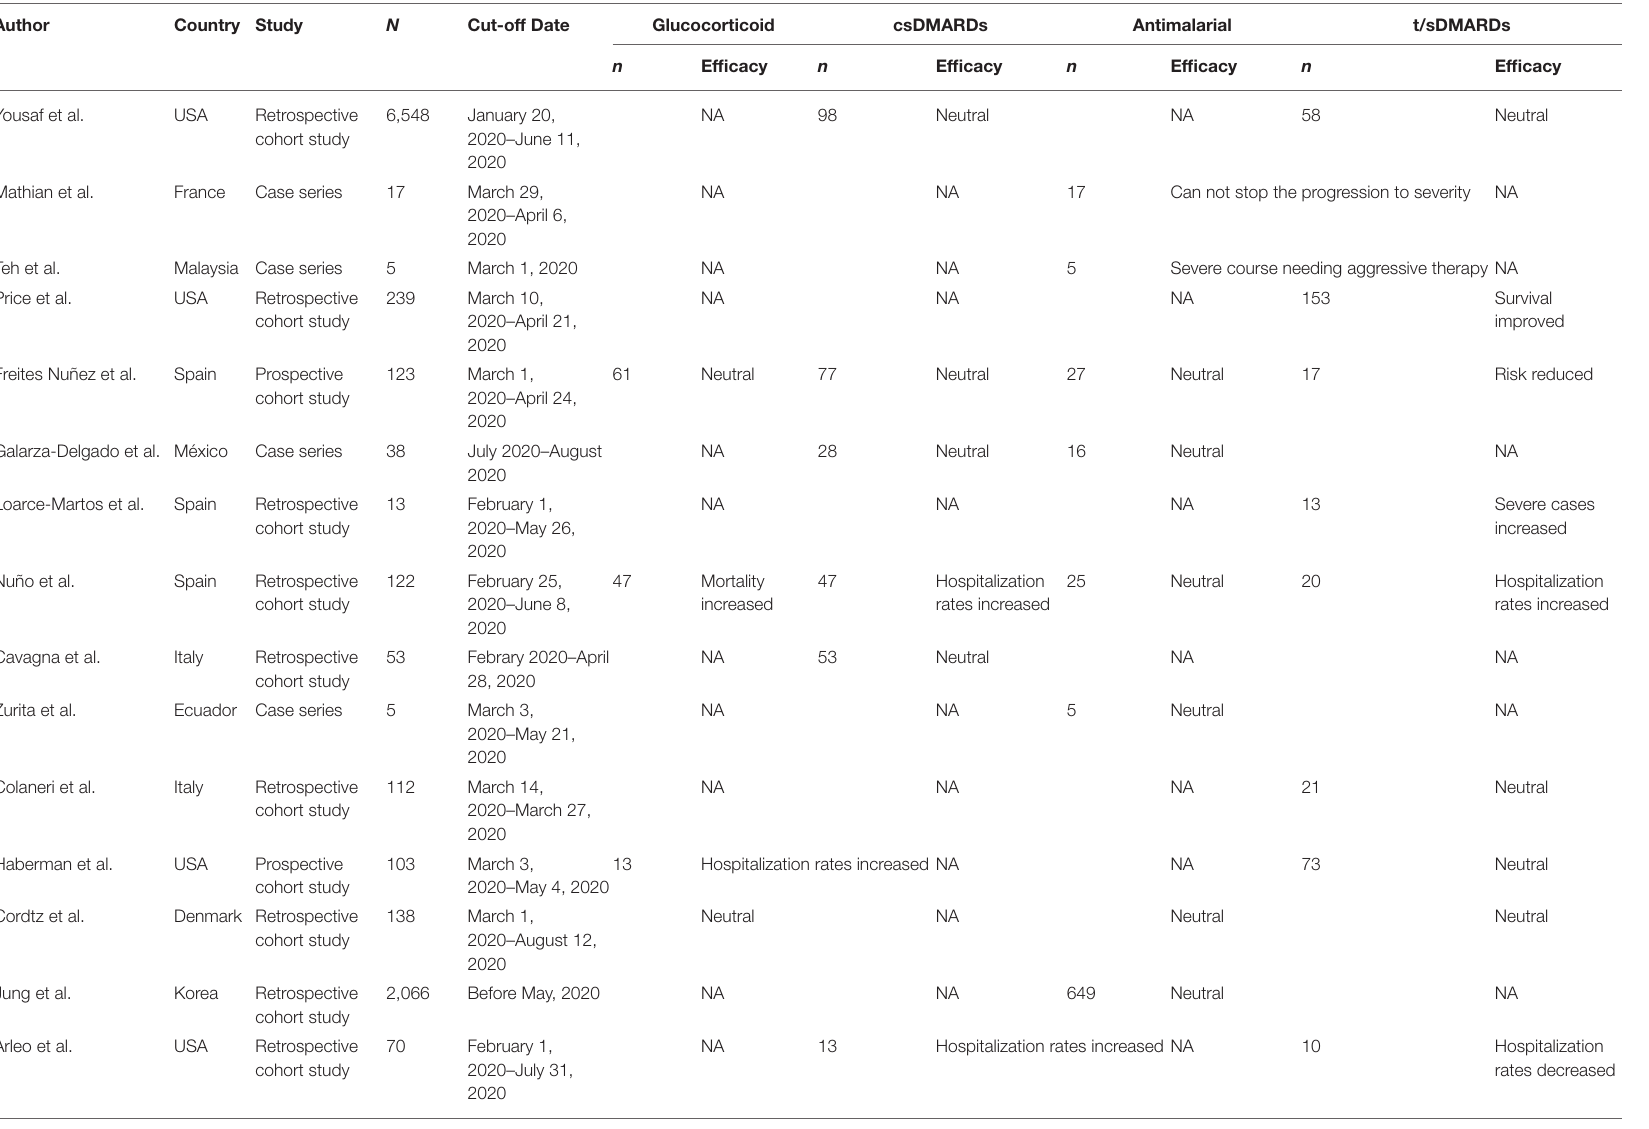
TABLE 3 | Treatments on RADs patients with